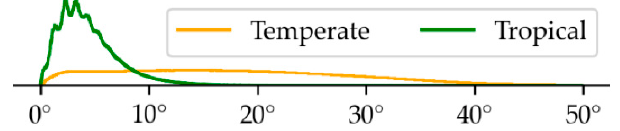
Figure 2. Frequency distribution of the slopes for forest pixels of both sites.